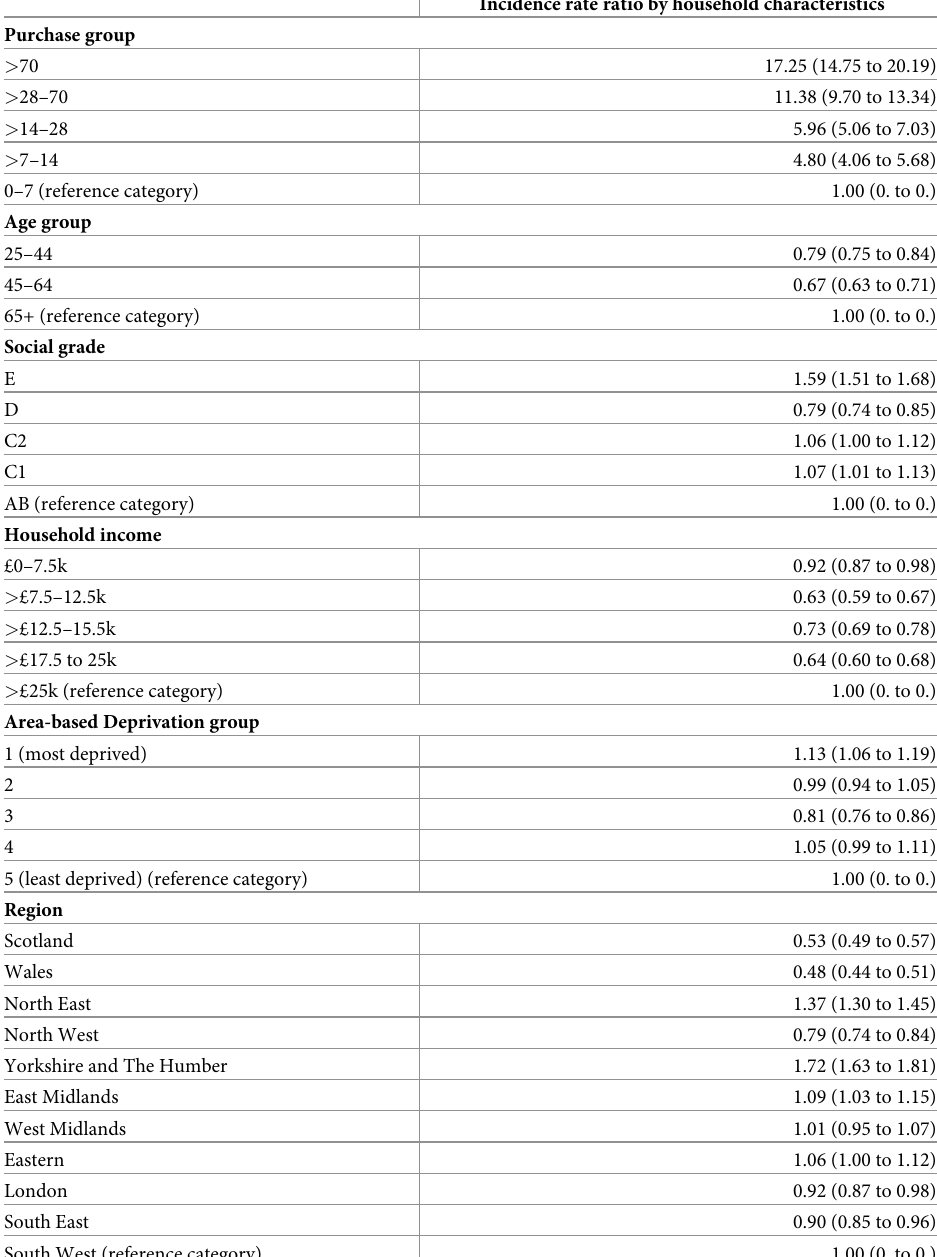
Incidence rate ratio by household